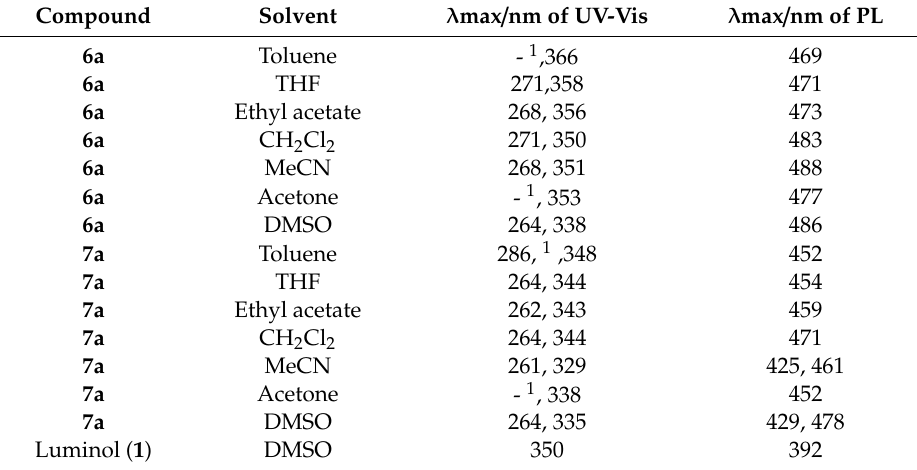
Table 2. UV-Vis absorption maximum and fluorescence emission peak wavelength of luminol ( 1 ), pyrazolopyridopyridazine dione 6a and N -aminopyrazolopyrrolopyridine dione 7a in the di ff erent